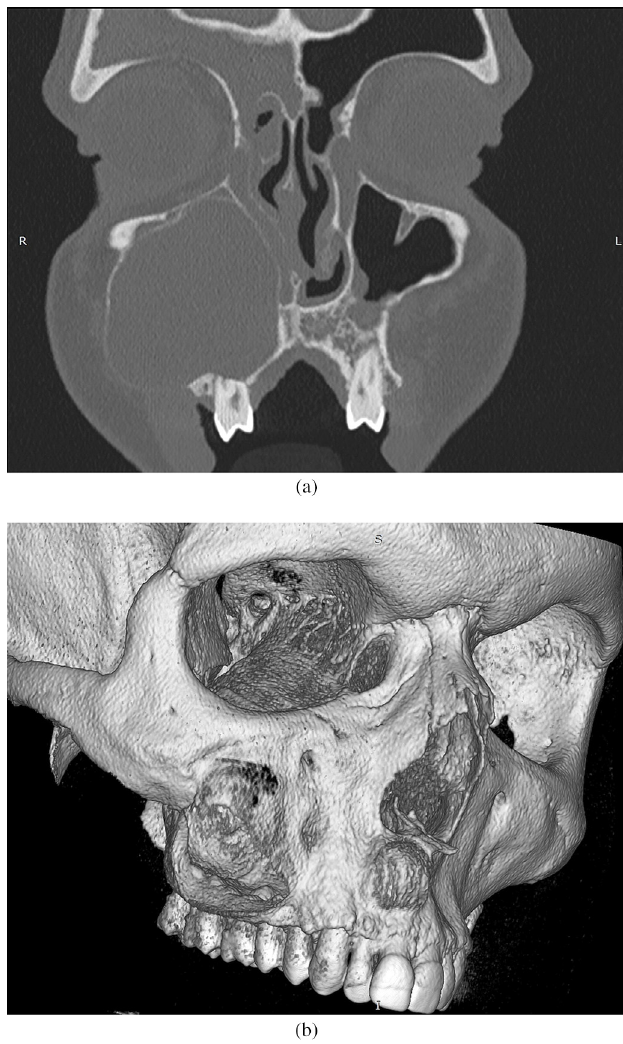
Fig. 2. Full thickness intraoral fl ap revealed the bone lesion (a). The solid part of the cystic coating consists of the growth of monomorphic medium/small rounded elements, alternating with deposits of eosinophilic matrix. Towards the luminal part of the solid growth, there are aggregates of ductal structures of elements of medium size, oval/cylindrical, with clear cytoplasm. At the center of some ductal structures there are intensely eosinophilic acellular droplets. To complete the lining of the cystic formation, towards the lumen, there is a similar epitheliomorphic/paucistrati fi ed lining